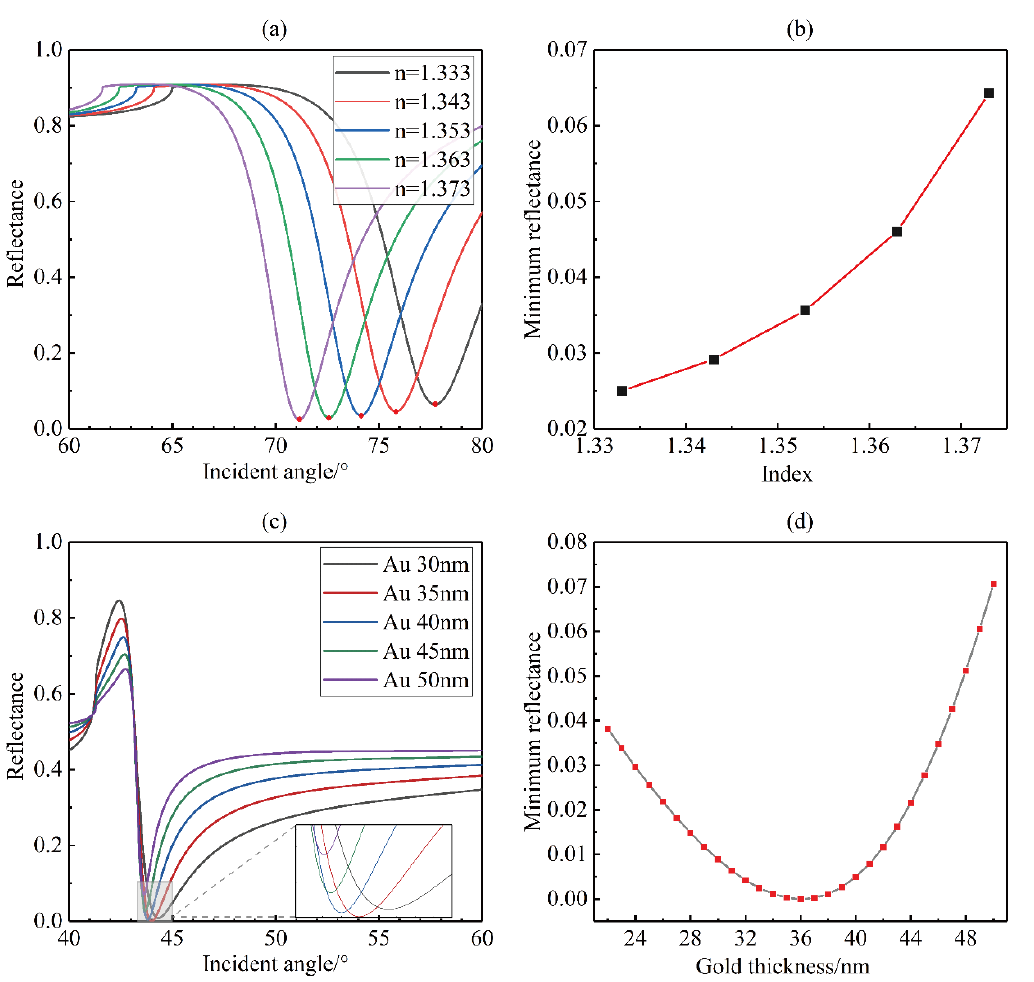
Figure 3. Simulation of optimized parameters for gas sensing: ( a ) intensity reflectance curves as the incident angle changes for different dielectric environments; ( b ) the minimum values of the intensity reflectance as the refractive index changes; ( c ) intensity reflectance curves as the incident angle changes for different thicknesses of gold film (light gray area at the bottom is enlarged to the small block diagram); ( d ) the minimum values of the intensity reflectance as the gold film thickness varies.